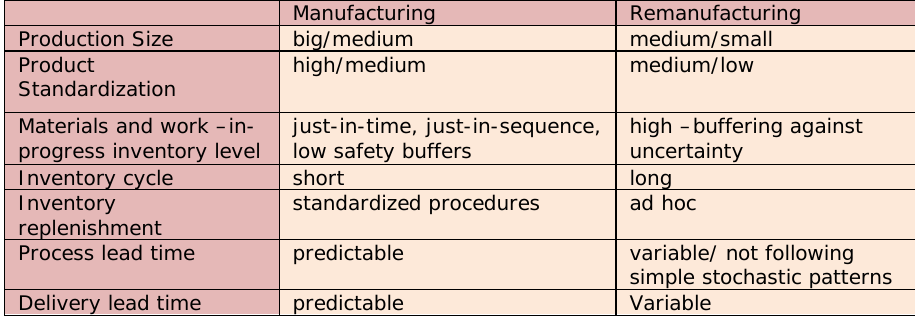
Table 1. Manufacturing vs.